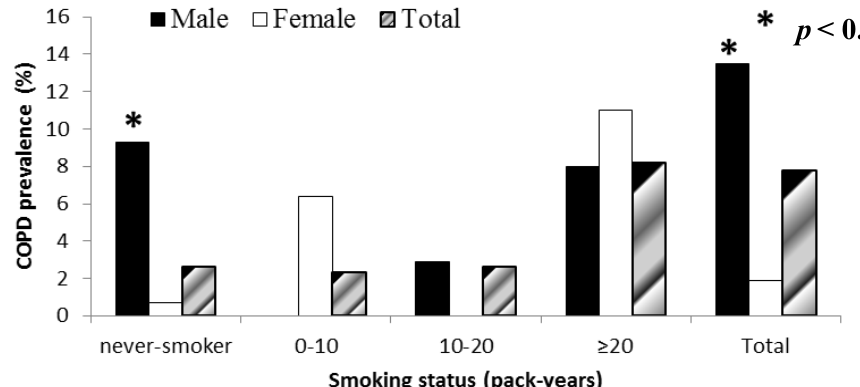
Figure 4. Prevalence of GOLD Stage II by pack years and